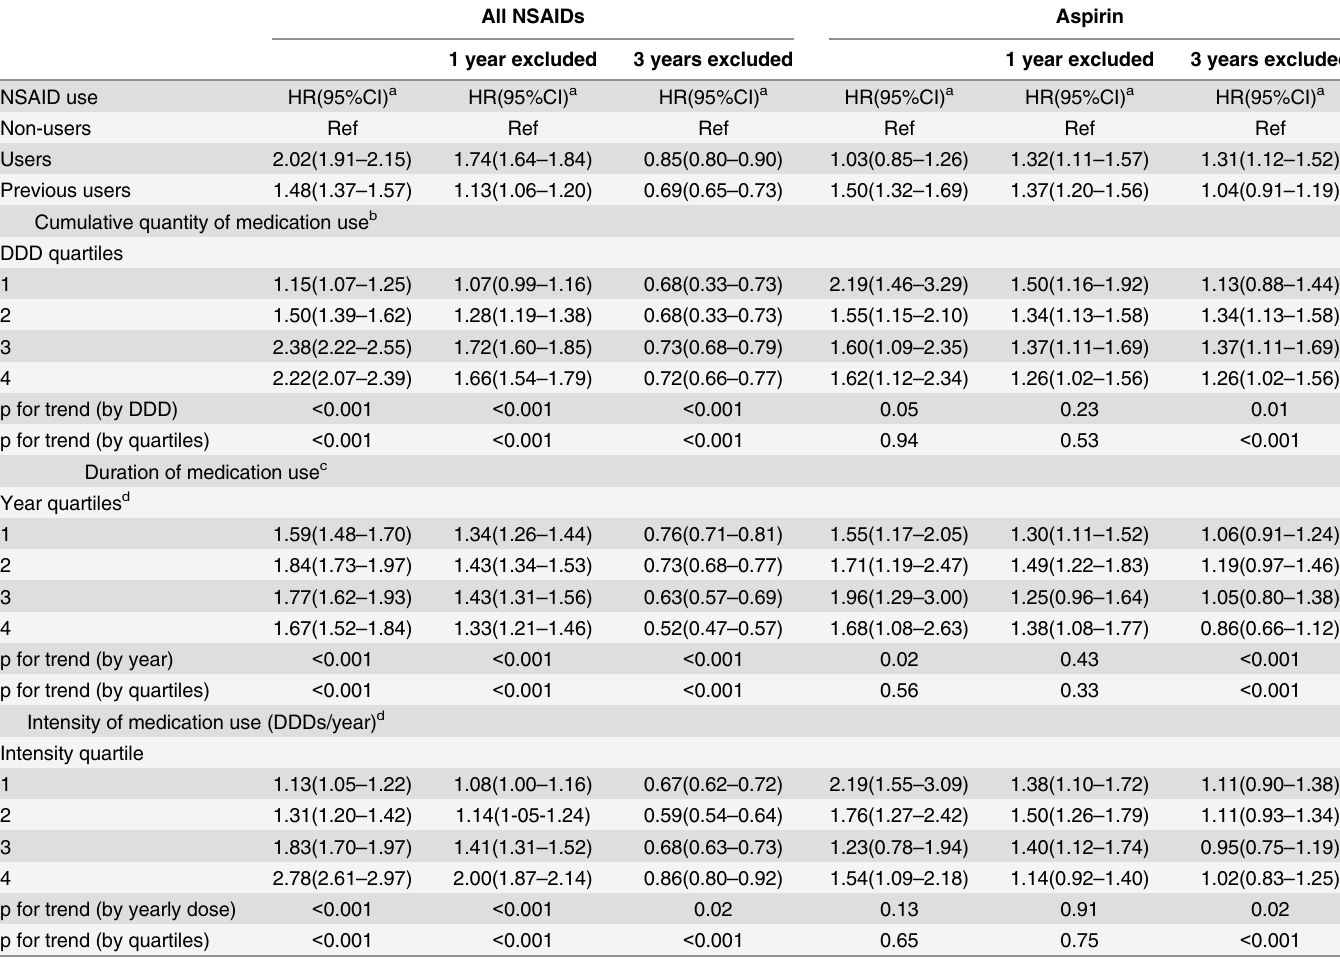
Table 3. Overall cancer mortality and lag time analyses by amount, duration and intensity of non-steroidal anti-inflammatory drugs in the Finnish Prostate Cancer Screening Trial during 1996 – 2012. All